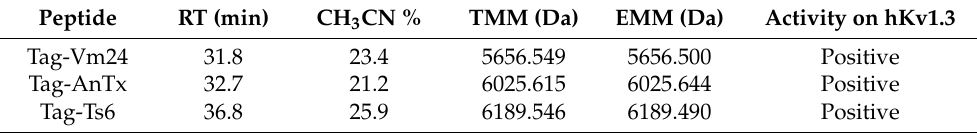
Figure 3. RP-HPLC purification of Vm24, AnTx, and Ts6. ( a ) RP-HPLC chromatograms of the recombinant peptides. Chromatograms show the fractions that are biologically active on the hKv1.3 channel. Acetonitrile % of elution and retention time for recombinant peptides were: Vm24 23.4%/31.8 min, AnTx 21.2%/32.7 min, and Ts6 25.9%/36.8 min. The inset in each chromatogram represents an ESI-QTOF-MS spectrum showing the monoisotopic mass of the respective fraction. ( b ) Sixteen percent tricine SDS-PAGE of the purified peptides. MM: molecular marker (kDa), line 1: Vm24, line 2: Ts6, and line 3: AnTx. Table 1. Initial characterization of the recombinant Vm24, AnTx, and